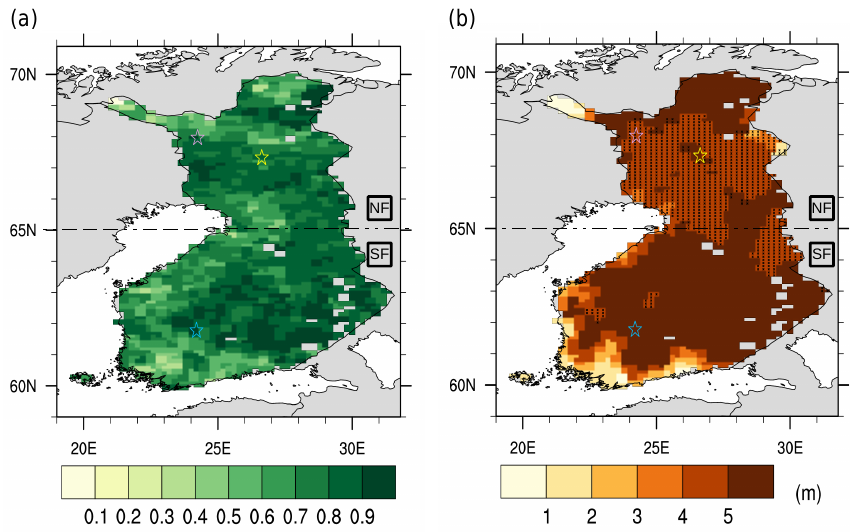
Figure 1. (a) The forest cover fraction over Finland in JSBACH derived according to Corine land cover 2006 data; (b) soil depth and the soil type (categorized as peatland and mineral soil) distributions in JSBACH over Finland (peatland area – dotted area; mineral soil area – area without dots). Northern (NF) and southern Finland (SF) are divided at the 65 ◦ N latitude. The location of the three ecosystem sites used in this study are marked as stars on the map (Blue–Hyytiälä; Yellow–Sodankylä; Pink–Kenttärova). The uncovered grid boxes (grey cells) in Finland represent inland